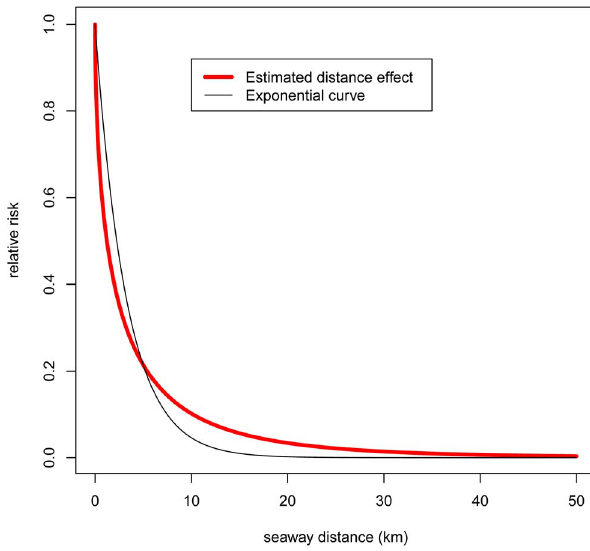
Figure 4. Estimated relative effect of the seaway distance.